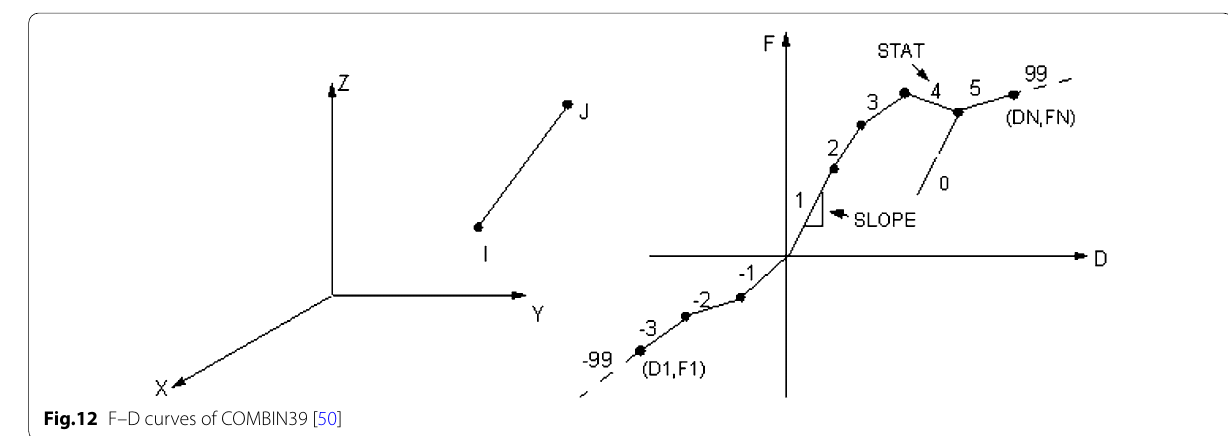
Fig.12 F–D curves of COMBIN39